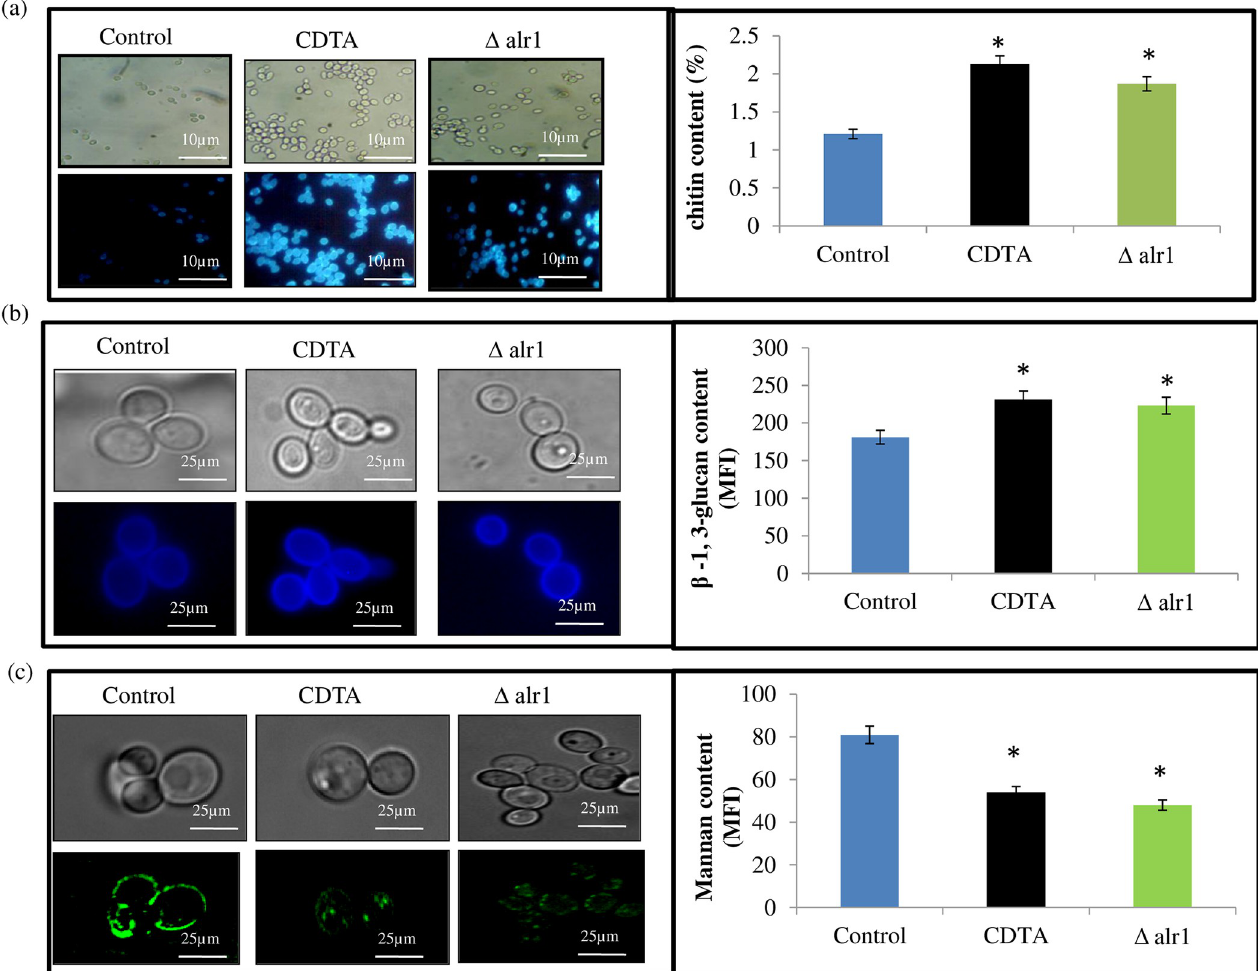
Fig 6. Changes in cell wall composition under Mg deprivation. Left panels depict representative fluorescent micrographs for control, CDTA treated and Δ alr1 C . albicans stained for ( a ) chitin (CFW), ( b ) β 1,3-glucan (AB) and ( c ) mannan (ConA). Scale bar = 25 μ m. Right panels depict the levels of (a) chitin (b) β 1,3-glucan and (c) mannan measured in control, CDTA treated and Δ alr1 C . albicans cells. The results represent the mean of three independent experiments, � depicts p value <